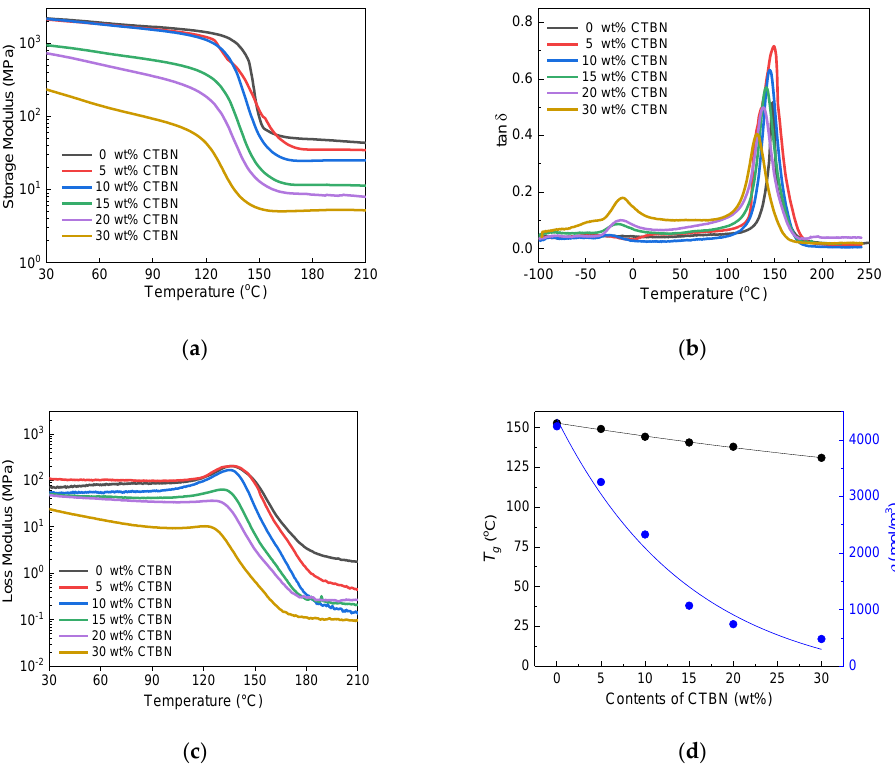
Figure 4. Storage modulus ( a ), loss tan δ ( b ), and loss modulus ( c ) curves of the CTBN-toughened epoxy adhesives and their T g and crosslink densities ( d ) as a function of the CTBN content. The GPC results show that CTBN has a much lower molecular weight ( M n : 6800) than PTPU ( M n : 18,700). CTBN may be more uniformly distributed in the epoxy network, causing a reduced crosslink density as compared with that caused by PTPU, owing to its small size and high miscibility. This observation is supported by the CTBN domain size, which is relatively smaller than that of PTPU. On the other hand, the reduced crosslink density of the PTPU-toughened epoxy adhesives could be explained, as follows. Based on the crosslink density and morphology of the PTPU-toughened epoxy adhesives, the sharp decrease in the crosslink density of the PTPU-toughened epoxy (at 5 wt % of PTPU) was believed to result from the hindrance of the curing reaction by the PTPU domains. However, as the PTPU content increased, more PTPU-epoxy adducts were formed and included in the network structure, alleviating the decrease in the crosslink density. In conclusion, it is believed that the crosslink density is determined by the degree of phase separation and the ease of toughening agent-epoxy adduct formation. Viscosity is also an important physical property of epoxy adhesives. Normally viscosity increases with the addition of PTPU or CTBN[46]. As shown in Figure 5, the viscosity of the PTPU- modified epoxy adhesive was twice as high as that of the CTBN-modified epoxy adhesive, because PTPU has higher viscosity than CTBN. Because too-high viscosity causes a wetting problem, more than 30 wt % of PTPU could not be used.